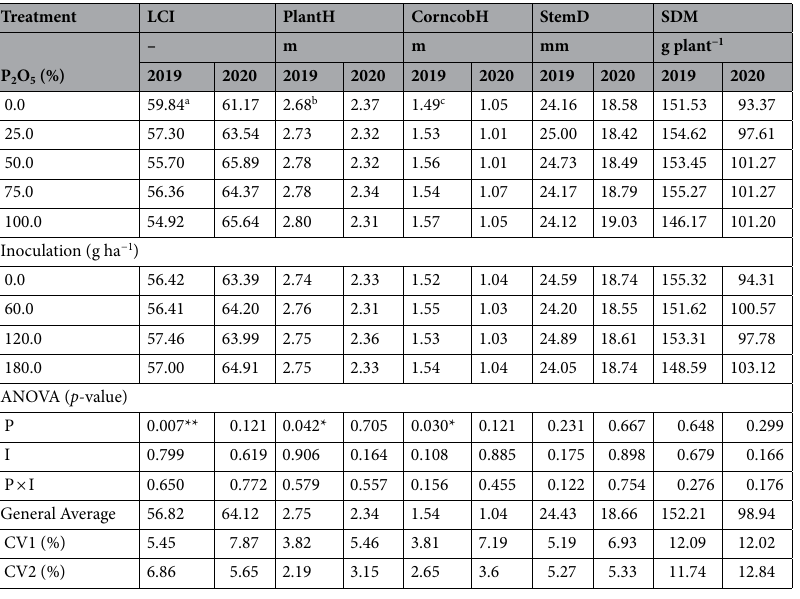
Table 2. Leaf chlorophyll index (LCI), plant height (PlantH), corncob insertion height (CorncobH), stem diameter (StemD), and shoot dry matter mass (SDM) as a function of added amounts of P 2 O 5 and inoculant containing Rhizophagus intraradices . CV: coefficient of variation (%). * and **significant at 5% and 1% by the F Test (ANOVA), respectively. a y = − 0.0431x + 58.98 (R 2 = 0.8055). b y = 0.0012x + 2.696 (R 2 = 0.8834). c y = 0.0007x + 1.504 (R 2 =